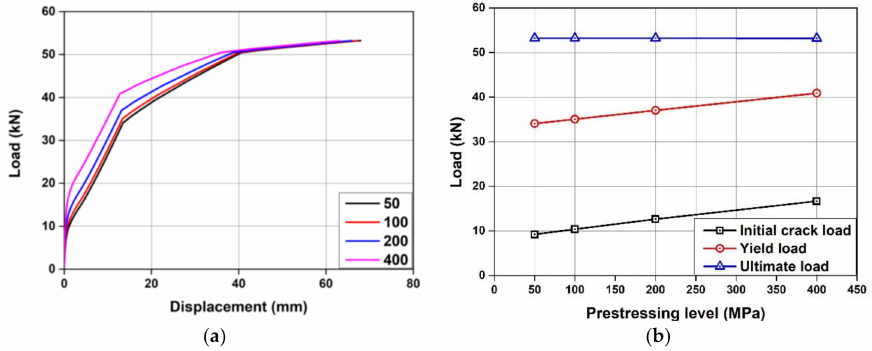
Figure 14. Effect of prestressing level (MPa): ( a ) Comparison of load- displacement curves; ( b ) Comparison of load stages for the number of Fe-SMA